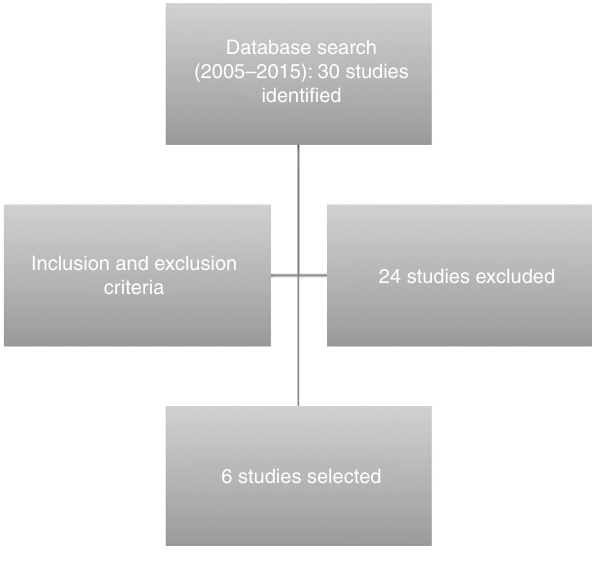
Database search and selection of studies.